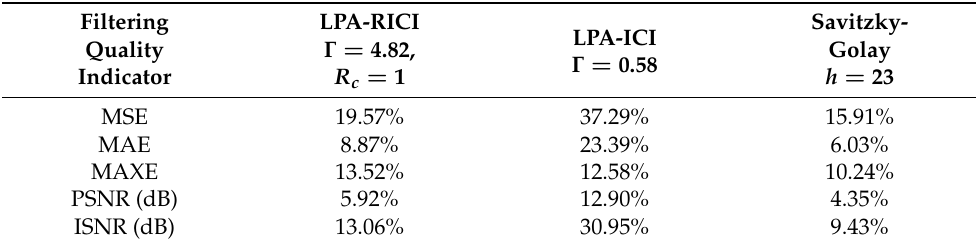
Table 18. Doppler signal (SNR = 5 dB)—Filtering quality improvement of the RBF-RICI-based filtering over other tested algorithms.